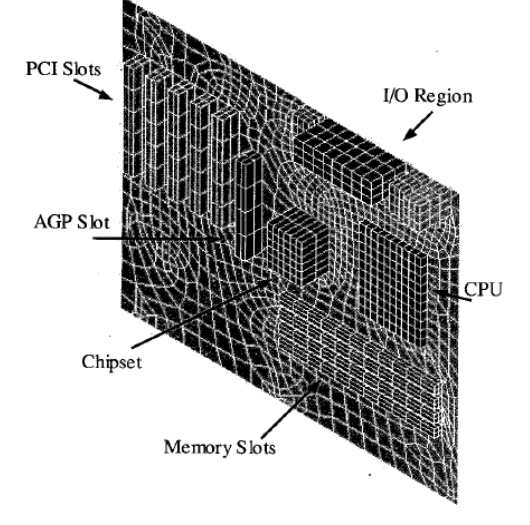
Fig. 1. Example of a detailed model of a PCB